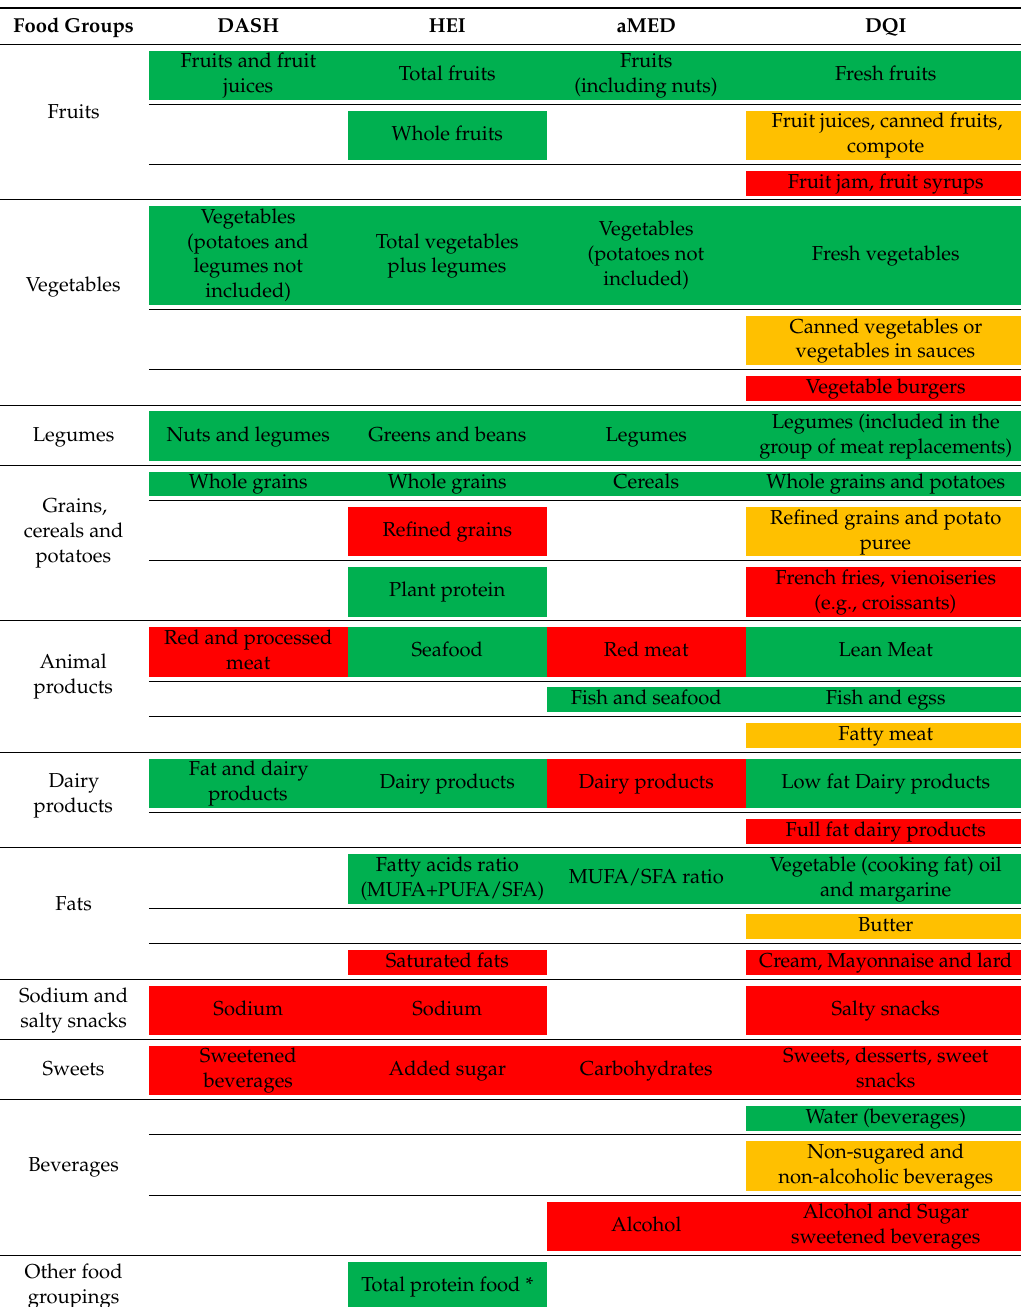
Table 1. Comparison of food components included in each diet score—in green: high intake recommended; in orange: moderate intake recommended (only applicable for the Diet Quality Index (DQI)); in red: low intake recommended. DASH: Dietary Approaches to Stop Hypertension; HEI: Healthy Eating Index; aMED: Mediterranean Diet